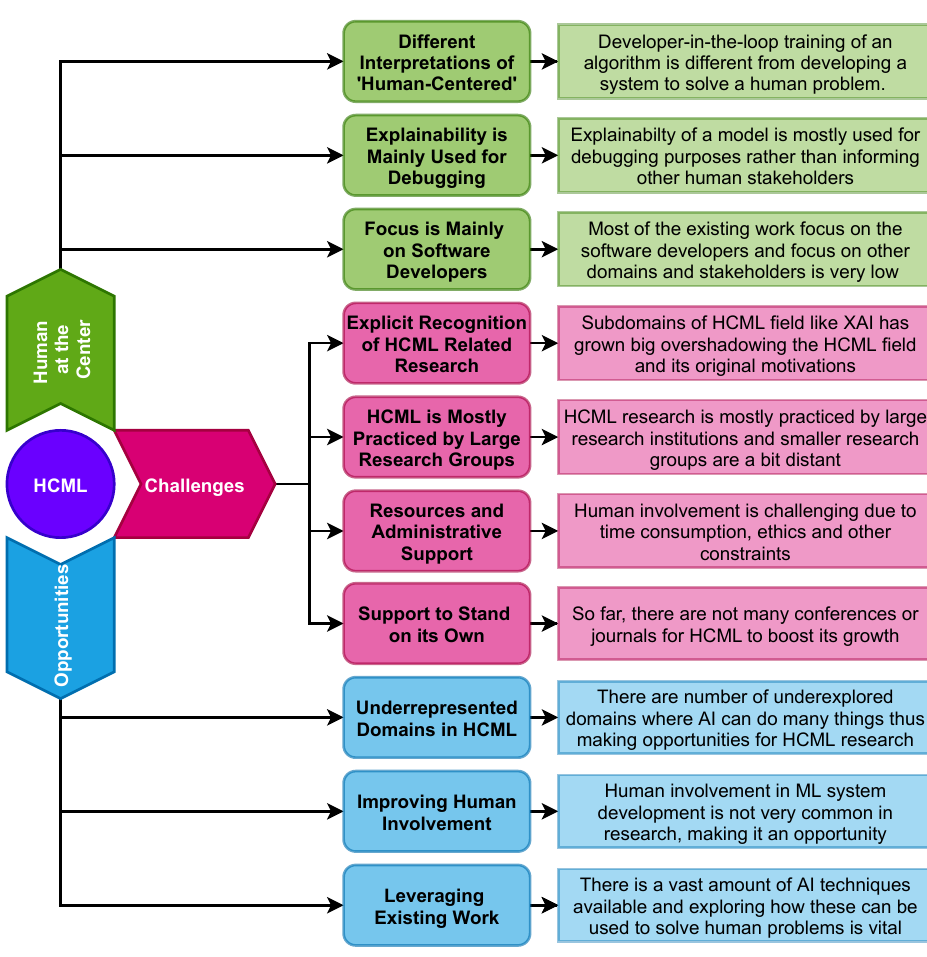
Figure 6. Summary of the Discussion Section. This figure represents the points discussed, and each point is followed by the main idea behind